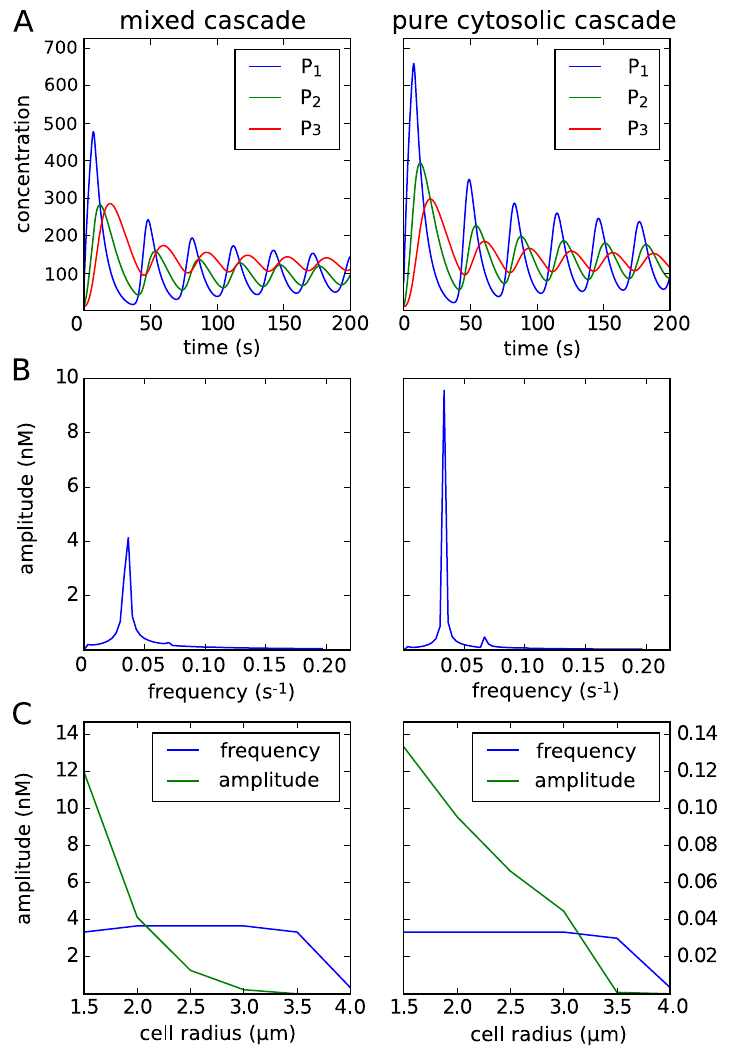
Fig 6. Size-dependent oscillations in a system with negative feedback. ( A ) Mean concentration of the P 1 , P 2 and respectively P 3 over time. After an initial peak both systems oscillate. Note that in case of the MMC, P 1 , P 2 concentration levels are given in n M μm ,while P 3 concentration is given in n M. For the PC cascade all concentrations P 1 , P 2 and P 3 are given in n M. ( B ) Frequency analysis of the mean concentration of both models for the last species, P 3 . ( C ) Frequency and amplitude of the mean concentration of P 3 for the two models in dependence of the cell